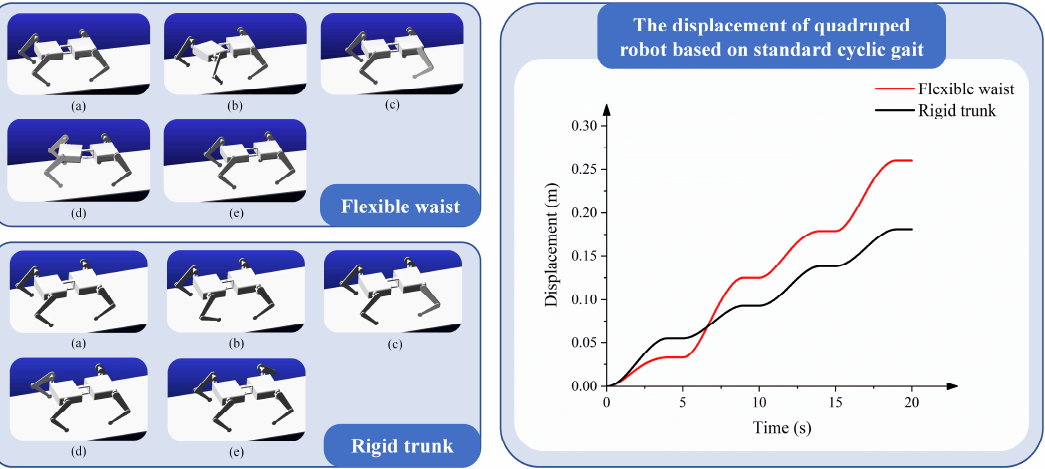
Figure 13. Simulation of walking gait: The left figures show motion process of robot with flexible waist and rigid trunk respectively; The right figure shows the displacement–time curves of the two kinds of robots.